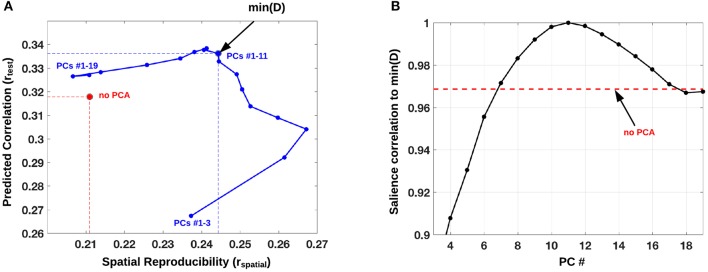
(A) PLS analysis performed on an adaptive optimized PCA subspace with mean predicted contrast-correlation of the significant LV plotted against the mean spatial reproducibility (blue). This PCA subspace was varied from 1 to k PCs with k = 19 (total number of scans in a split-half), and its performance was defined as the distance D from rspatial = 1 and rtest = 1. A subspace of PCs 1–6 minimized D, which is displayed as a blue dot with a black circle. As a reference we also plot the mean (rspatial, rtest) point, directly estimated from matrix X (red circle). (B) Correlation of brain pattern (salience) to min(D, k = 11) across different choices of k (PC #). The red dotted line indicates the correlation between the salience brain pattern for min(D, k = 11) and the salience brain pattern without PC-subspace optimization.